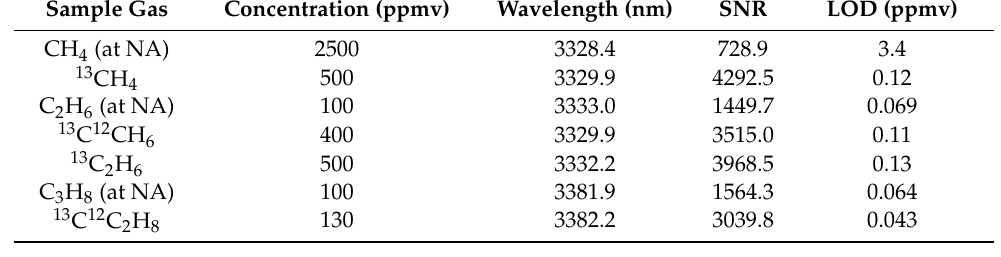
Table 2. Idealized detection limits of the PA setup. The signal-to-noise ratio (SNR) of each sample spectrum was obtained at these wavelengths.